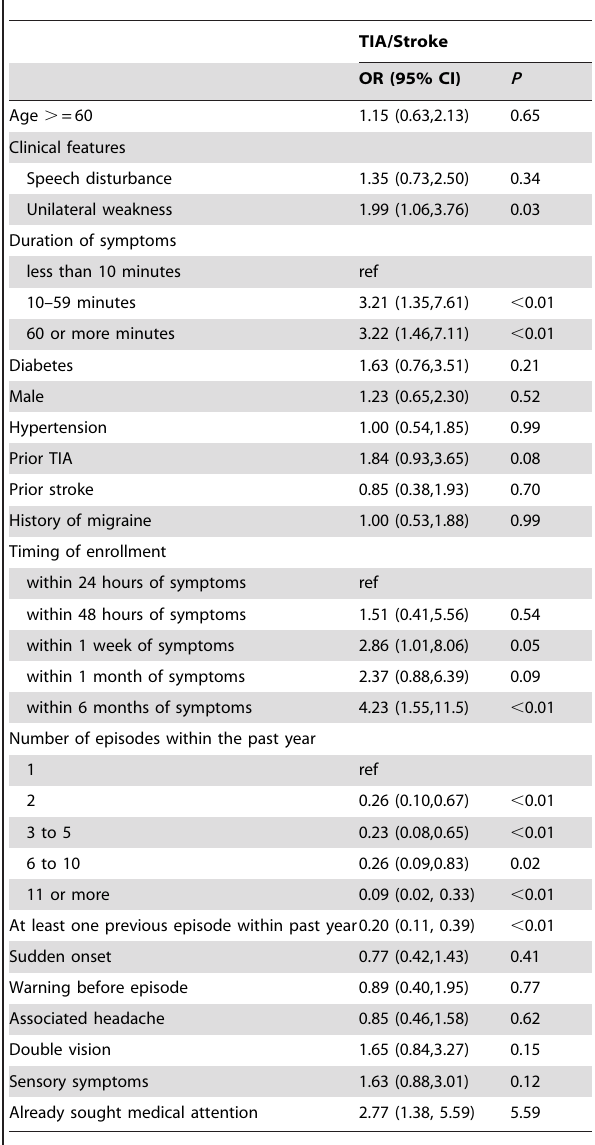
Table 2. Univariable Predictors of Cerebrovascular Outcomes Among 175 Users Searching for Information on Transient Ischemic Attack and Mini-Stroke